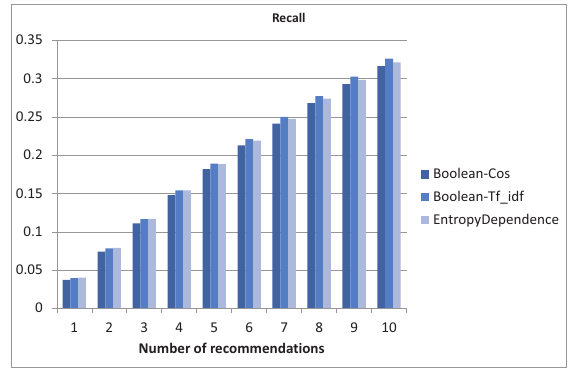
Fig. 3. Recall of the algorithms according to number of recommen-